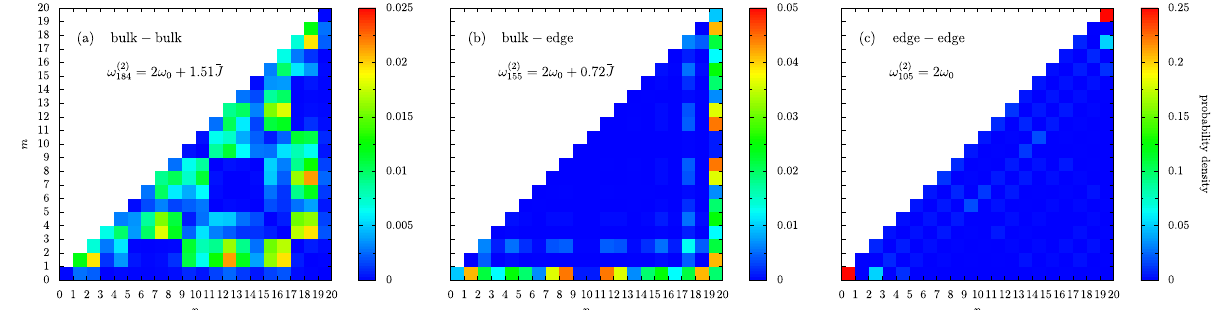
Figure 4. Three typical eigenstates of a dimerized chain in the two excitation sector, with vanishing interactions 0 ). Color bars: probability densities (note: the scale is different for each panel). In the figure, the ( U → 10 dimers, leading to a 210-dimensional 1 / 2 and the chain is composed of N dimerization parameter ǫ = = − Hilbert space. This regime corresponds to descending the thin, gray vertical line in Fig.